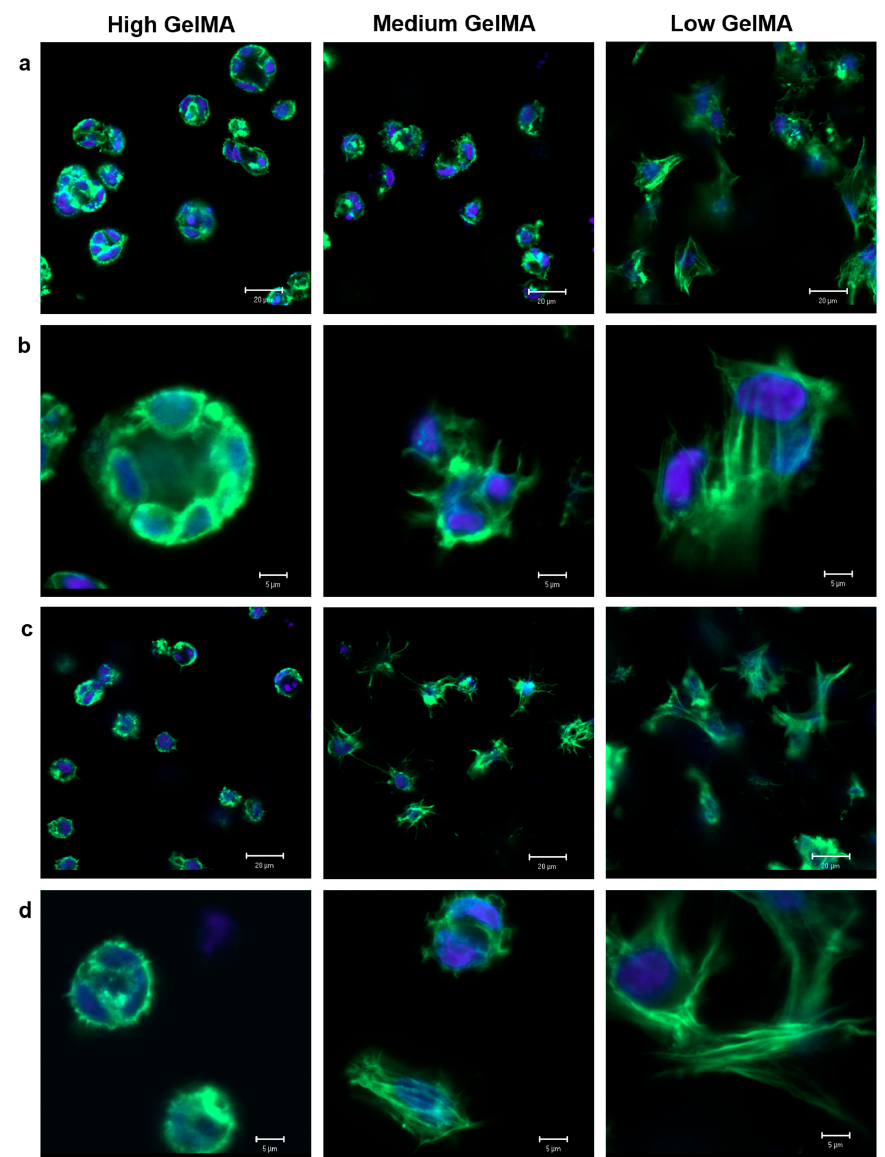
Figure 6. Confocal laser microscopy images of chondrocytes that were stained with F-actin (green) and cell nuclei (blue) after being cultured in GelMA hydrogels for seven days ( a , b ) and 14 days ( c , d ). ( a , c ) scale bar = 20 μ m; ( b , d ) scale bar = 5 μ m.